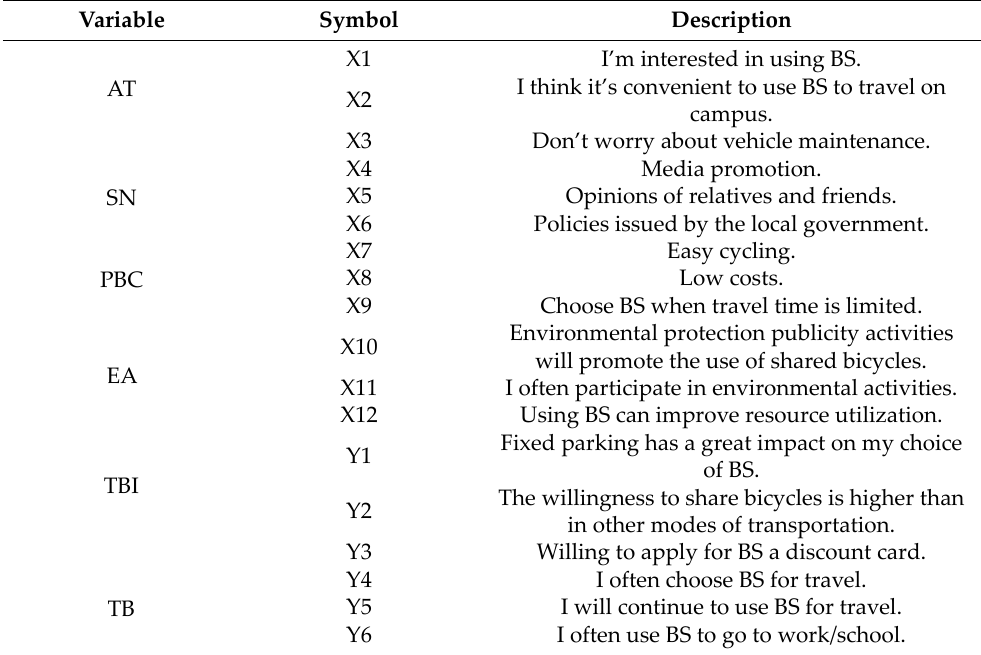
Table 1. Description of model